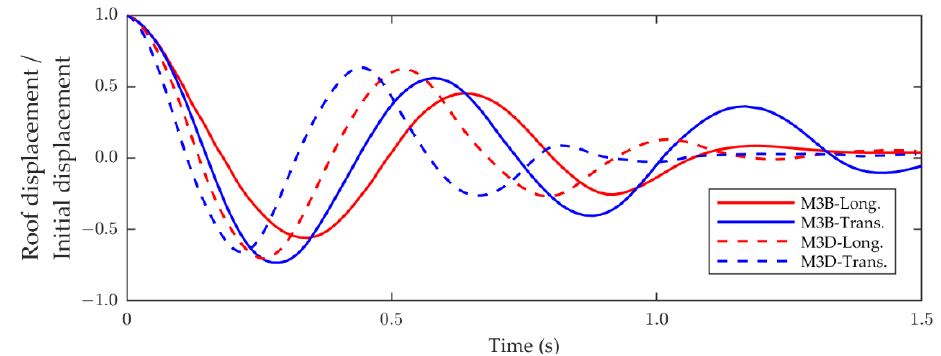
Figure 11. Free vibration tests for M3B and M3D models.